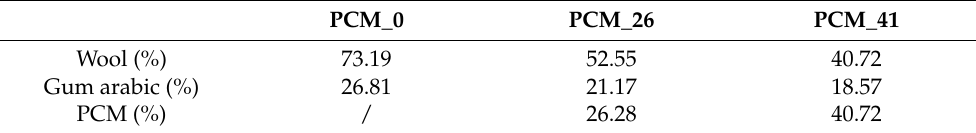
Table 2. Weigh percentage of the materials present in the specimens after squeezing.